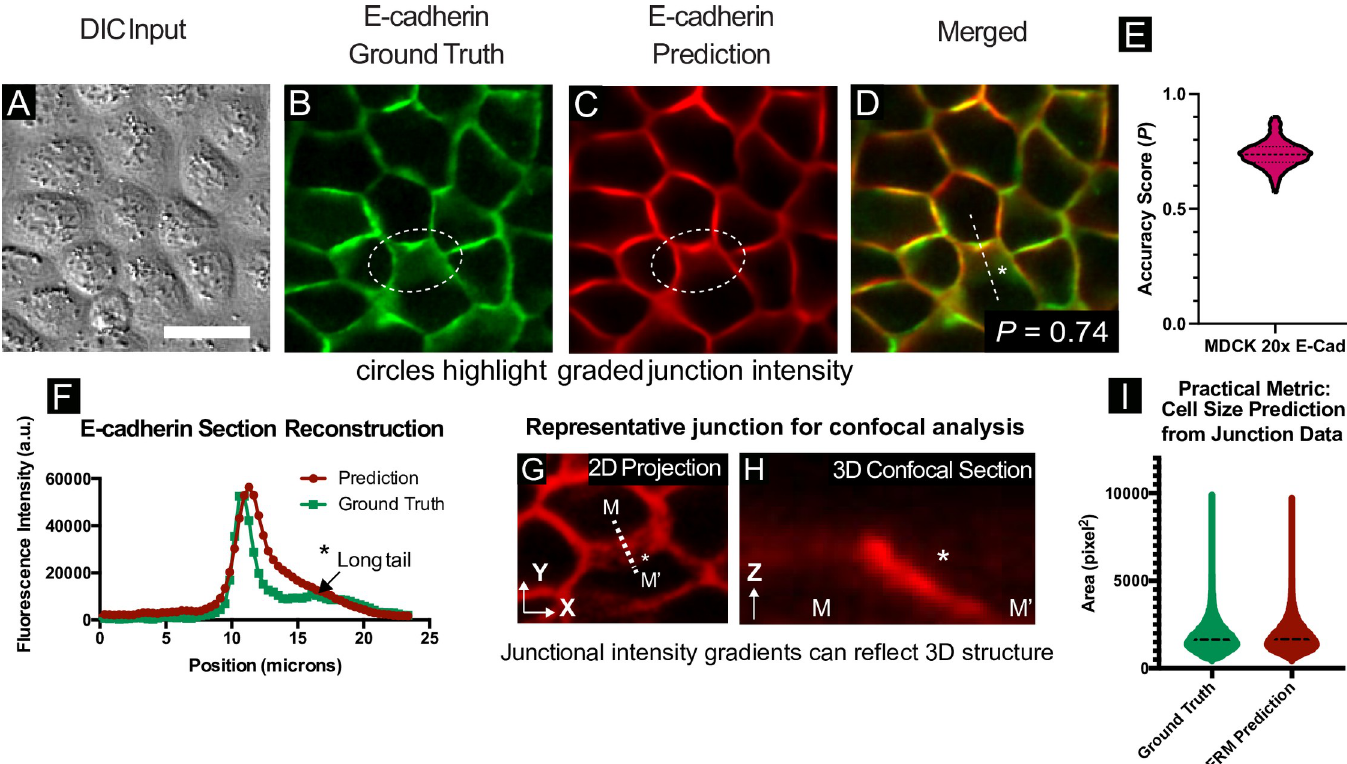
Fig 3. Cell-cell junction reconstruction from DIC data and capturing otherwise invisible morphology. (A-D) Images of MDCK WT cells at 20x magnification were processed using a neural network trained to reconstruct cell-cell E-cadherin junctions. Representative ground truth features are shown alongside, and merged with, network predictions. The scale bar is 30 μ m. (E) Ensemble statistics for E-cadherin reconstruction; N = 4539 test images, see S1 Table. (F) Line sections from identical spatial regions in (B) and (C) highlight the accuracy of predicted fluorescence intensity across cell-cell junctions (normalized to 16-bit histogram). From 2D transmitted light input (A), 3D structures may be detected. (G, H) Representative cell-cell junction and corresponding confocal section, highlighting the relationship between 2D junction signal and 3D features. ‘ � ’ in (G) is 7 μ m above the basal plane. (I) Practical metric assessing estimated cell areas for entire E-cadherin training set (~30,000 individual cells). Junction segmentation was used to calculate cell areas for ground truth and FRM predictions and the distributions of detected cell areas were plotted for comparison. Ground truth mean area was 1813 pix 2 ; FRM predicted mean area was 1791 pix 2 .